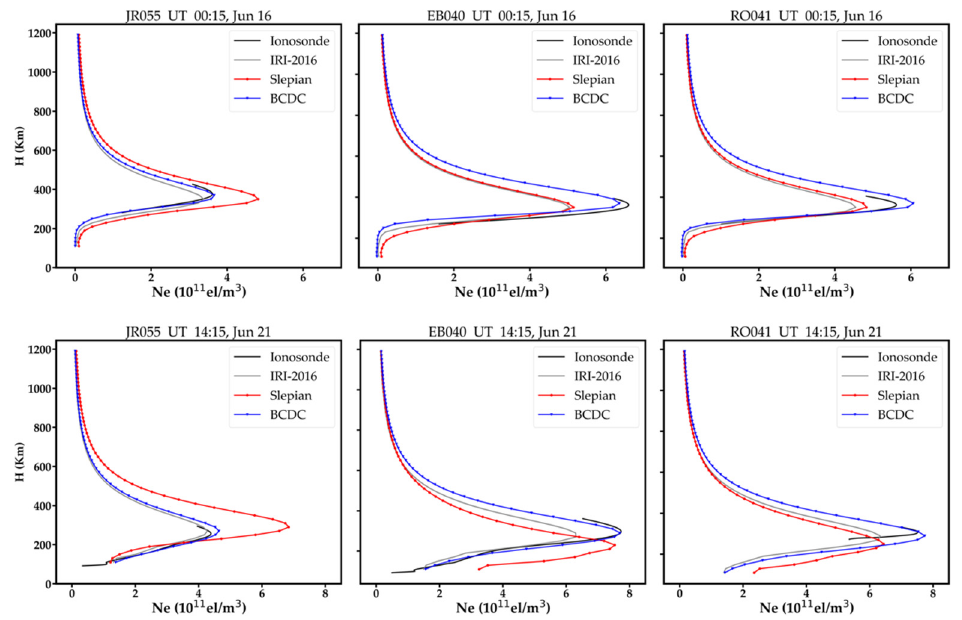
Figure 7. Vertical profiles obtained by the BCDC method, the Slepian method and the IRI − 2016 model against those observed at JR055, EB040 and RO041 stations during the geomagnetic quiet time.